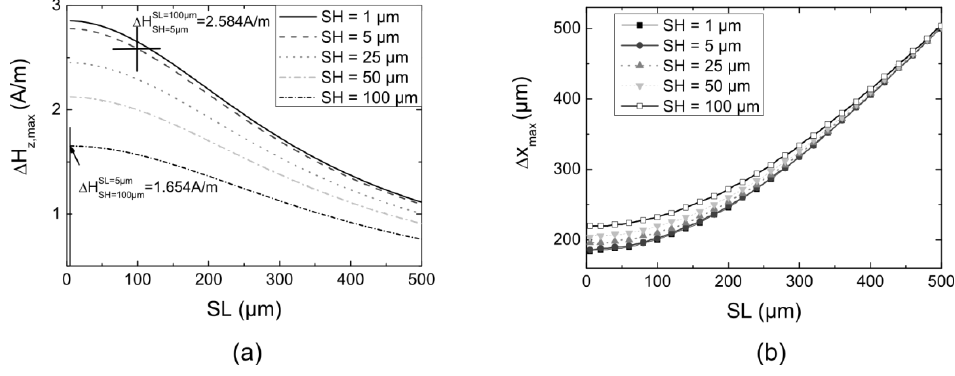
Figure 5. Simulation results of the normal gradiometer with LO = 150 µm and BL = 250 µm (defect: depth 50 µm, width 2 µm and length 500 µm). ( a ) Maximum MFL Δ H function of the sensor length SL for different sensor heights SH . Two magnetic field points are highlighted for sensors with the same sensor area but with different SL and SH ; ( b ) Diagram of the distance Δ x as a function of SL for several SH max